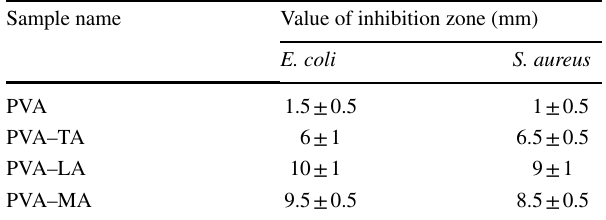
Table 1 Antibacterial activity of prepared PVA and PVA/OA poly- mer solutions against different